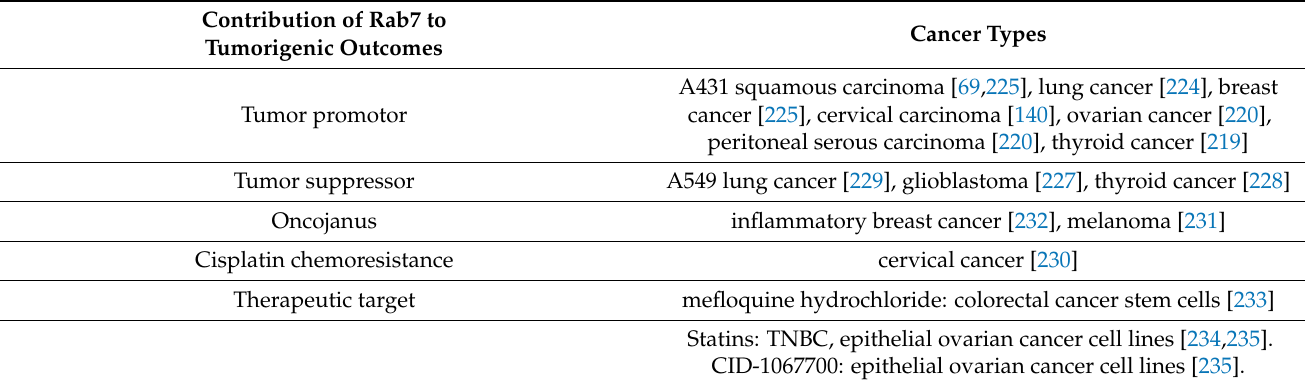
Table 4. Roles of Rab7 in